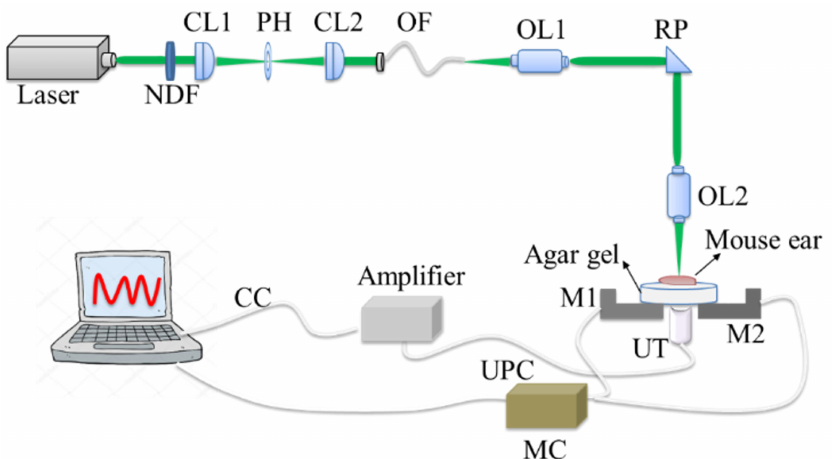
Figure 1. The home-made optical-resolution photoacoustic microscopy (PAM) imaging system. NDF: